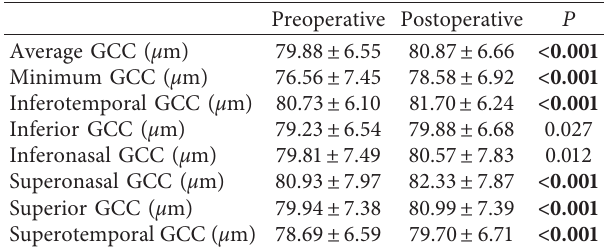
Table 2: Pre- and postoperative values of ganglion cell complex (GCC) for classic phacoemulsification cataract surgery.